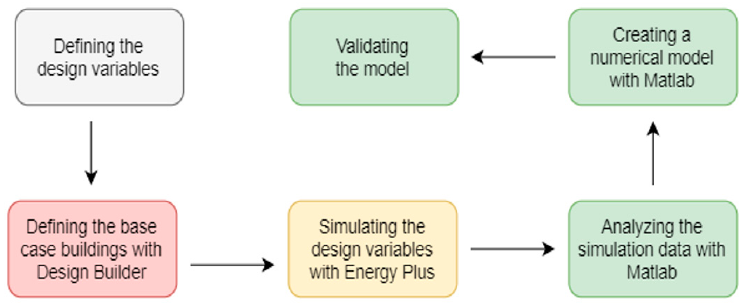
Figure 1. Methodology of work carried out.